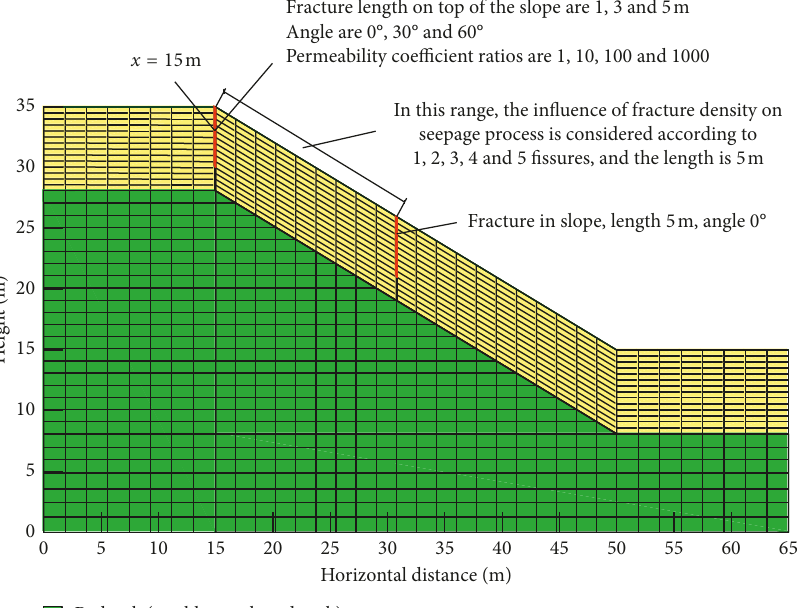
Figure 2: Numerical calculation